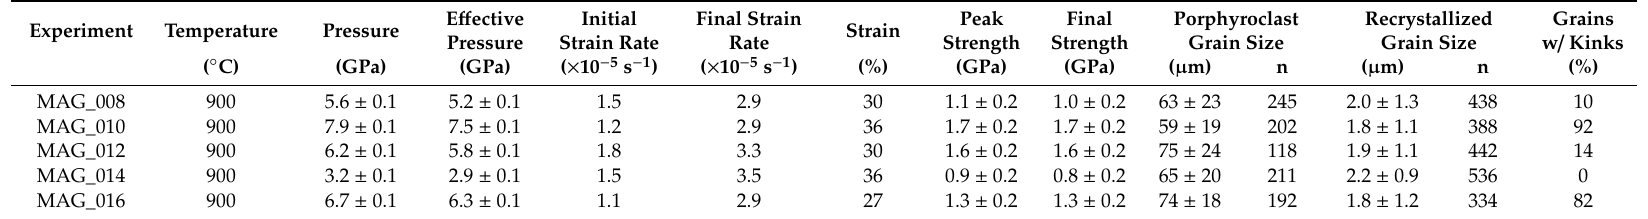
Table 3. List of experiments performed on coarse-grained Nevada